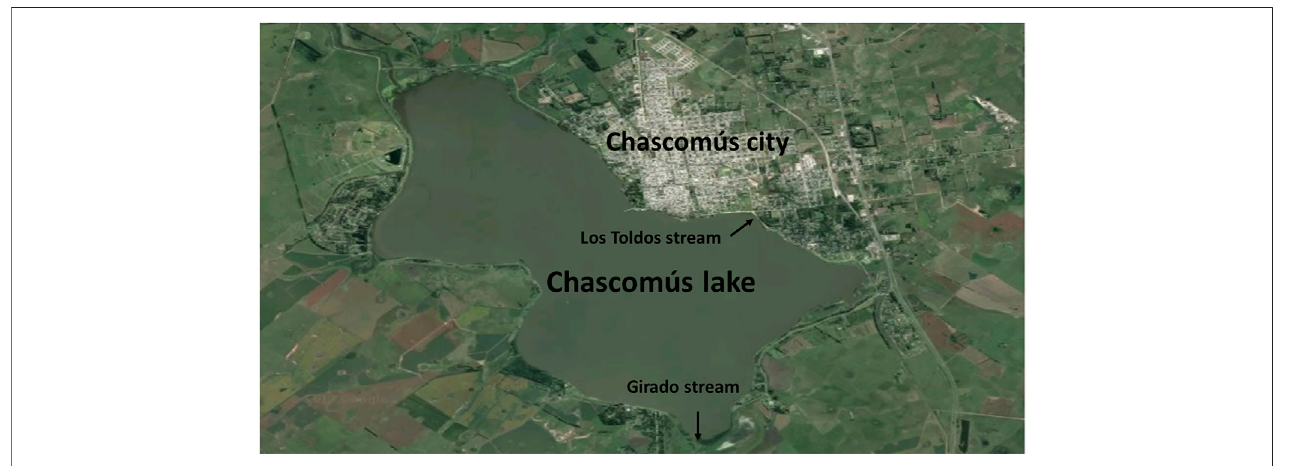
FIGURE 1 | Satellite photography of Chascomús